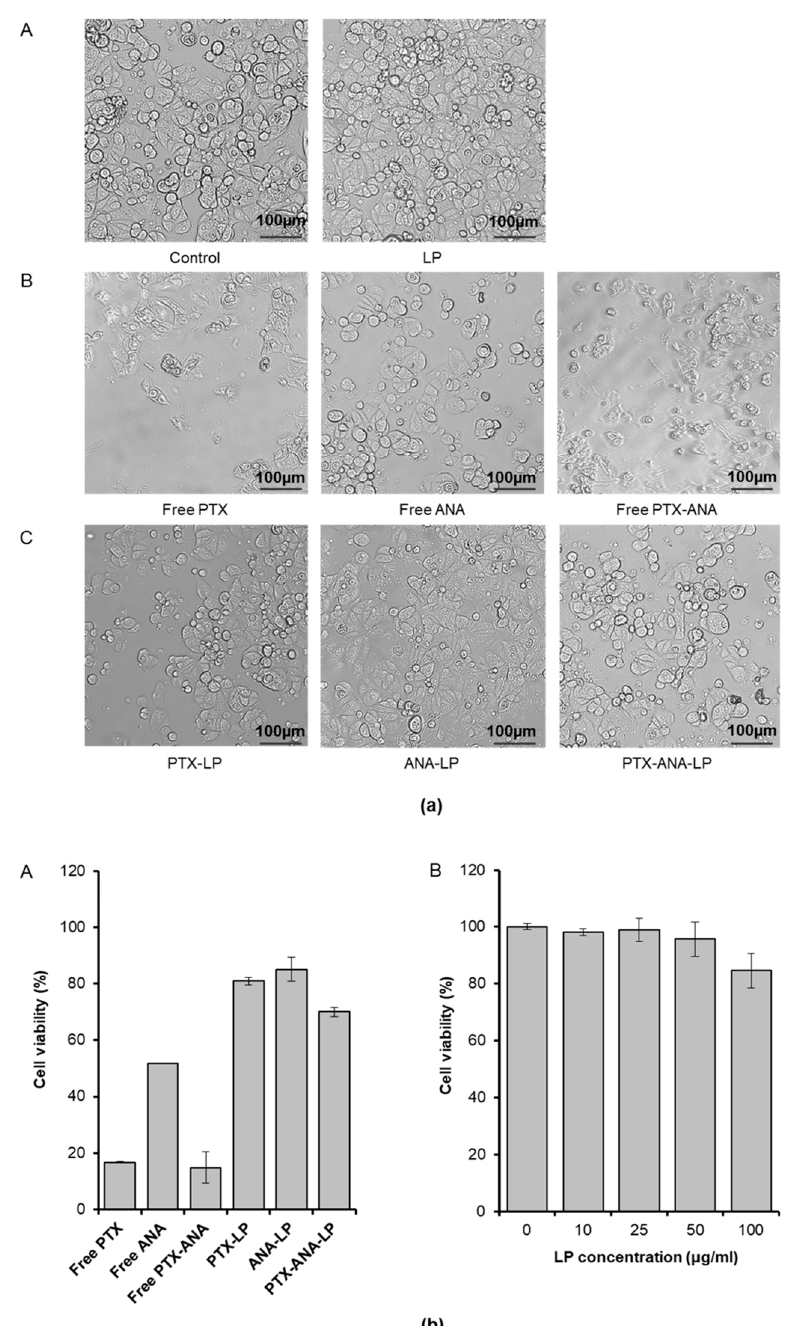
Figure 4. ( a ) Images of c-7 cells incubated with ( A ) Control, LP (100 µ g / mL), ( B ) free PTX, free ANA and free PTX-ANA, and ( C ) PTX-LP, ANA-LP and PTX-ANA-LP for 24 h at a concentration of 1 µ g / mL (scale bar = 100 nm). ( b ) Viability of MCF-7 cells incubated with ( A ) free PTX, free ANA, free PTX-ANA, PTX-LP, ANA-LP and PTX-ANA-LP at a concentration of 1 µ g / mL and ( B ) LP at di ff erent concentrations for 24 h. The data represent the mean values ± the standard deviation (SD) ( n = 4). Free PTX, free ANA, and free PTX-ANA showed a cell viability of 17%, 51%, and 15%,